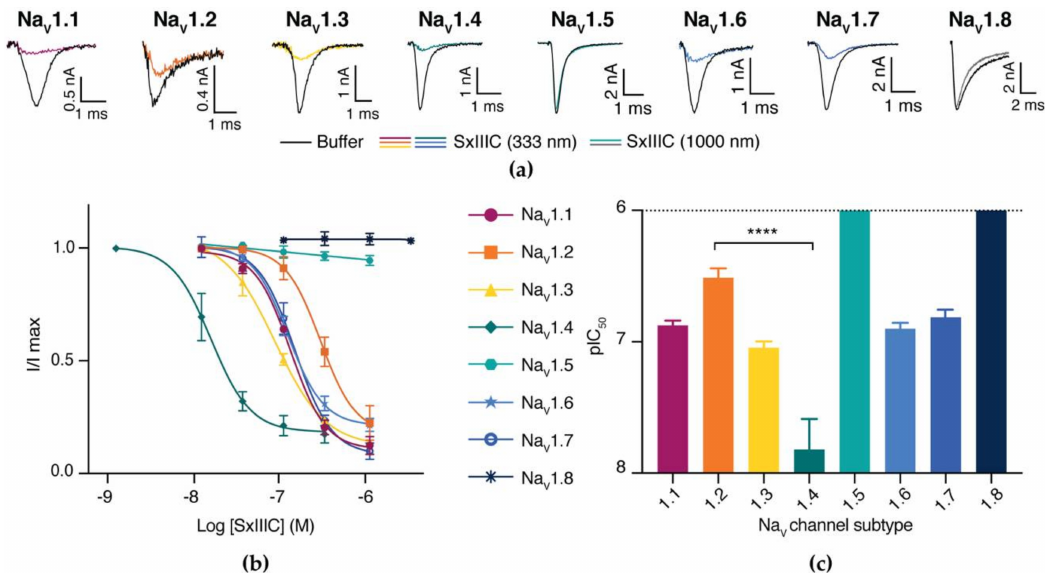
Figure 3. Activity of SxIIIC across Na V channel subtypes assessed by whole-cell patch-clamp electrophysiology. ( a ) Representative hNa V 1.1–1.8 current traces before (black line) and after addition of SxIIIC (333 or 1000 nM; coloured line). Currents were obtained by a 50 ms pulse to − 20 mV for hNa V 1.1–1.7 and + 10 mV for hNa V 1.8. ( b ) Concentration-response curves and ( c ) comparative IC 50 potency of SxIIIC at hNa V 1.1–1.8. SxIIIC most potently inhibited Na V 1.4, with 10-fold selectivity over hNa V 1.1, 1.3, 1.6 and 1.7, 24-fold selectivity over hNa V 1.2 (****, p -value < 0.0001) and > 100-fold selectivity over hNa V 1.5 and hNa V 1.8. Data are presented as mean ± SEM, with n = 3–10 cells per data point, see Table